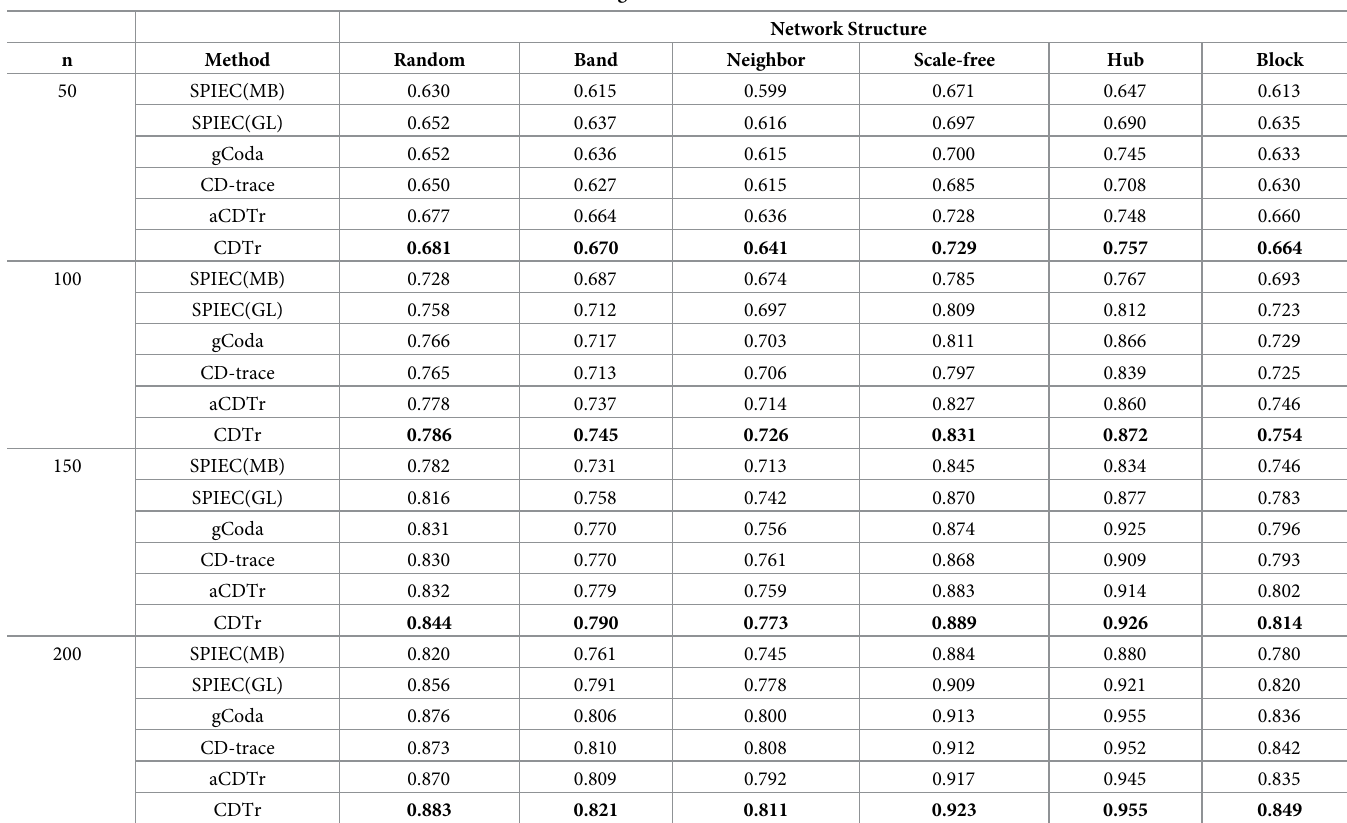
Table 4. The mean AUC scores of different methods under different